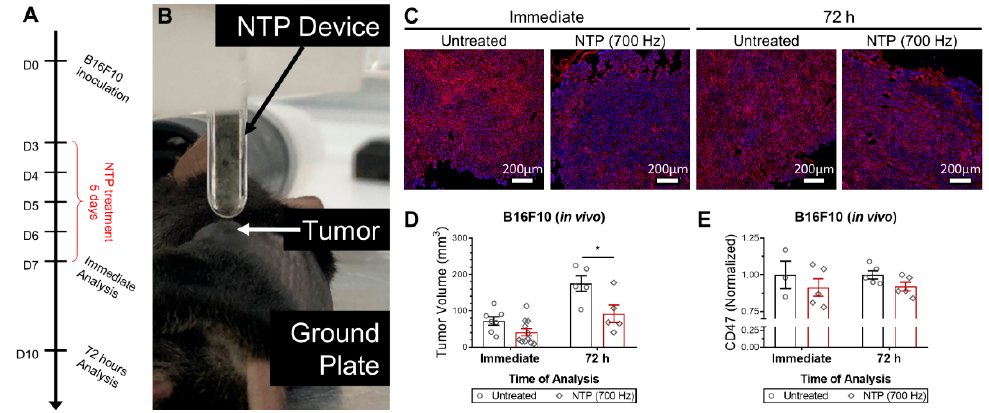
Figure 3. NTP treatment reduced tumor volume and decreased CD47 expression, slightly, in vivo. ( A ) A schematic of the experimental design is provided. ( B ) B16F10 melanoma tumors were established in syngeneic B57BL/6 mice and treated directly with NTP for 5 consecutive days. Following treatment, tumors were resected immediately or 72 h post treatment and ( C ) stained for CD47 (red) and counterstained with DAPI (blue). All images were taken on the same day at 20× and batch processed for quantification to limit variations. ( D ) Tumor volumes were also reduced after treatment. ( E ) Quantification of CD47 was normalized to the untreated. Data here are represented as mean ± SEM and individual values are also shown (n = 3–11). Statistical significance of all treatment conditions was determined using the generalized linear mixed model with post hoc Dunnett’s test comparison to untreated (* p ≤ 0.05).